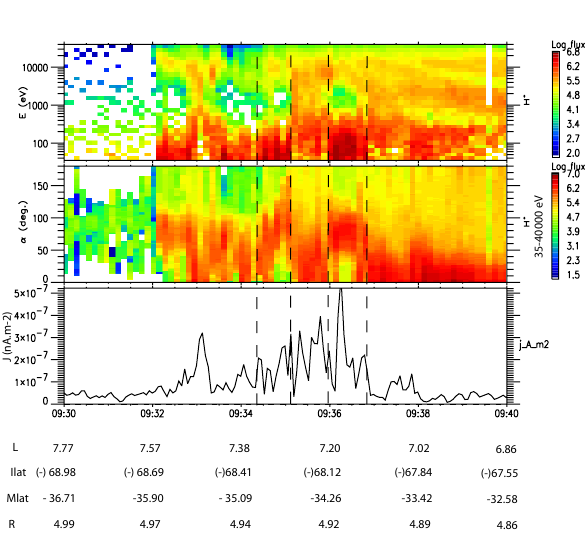
Fig. 10. Inner plasma sheet zoom for the 18 March 2002 event: H + energy-time spectrogram in particle flux units (ions/cm 2 srskeV), pitch angle distribution for the 35–40000eV energy range in par- ticle flux units (ions / cm 2 sr skeV) and total current density in nA.m − 2 . L-shell, invariant latitudes, magnetic latitudes and geo- centric distances are indicated